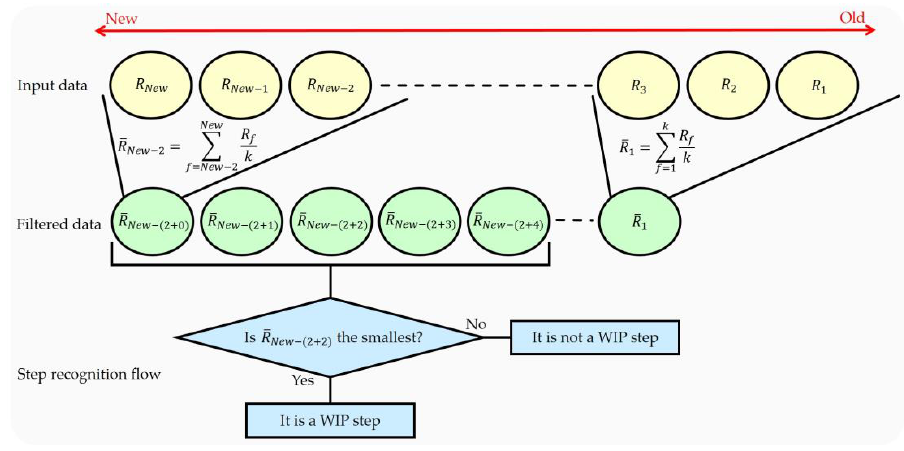
Figure 7. The step recognition process when the moving average filter ( k ) = 3 and the size of the queue ( n ) = 5. Where 𝑅 is input 𝑌 𝑝𝑜𝑠 data, f is a frame number, and 𝑅̅ is filtered data. The yellow circle is the input data and the green circle is the filtered data through the moving average filter. The blue diagram shows the process of recognizing a WIP step based on the filtered n data.